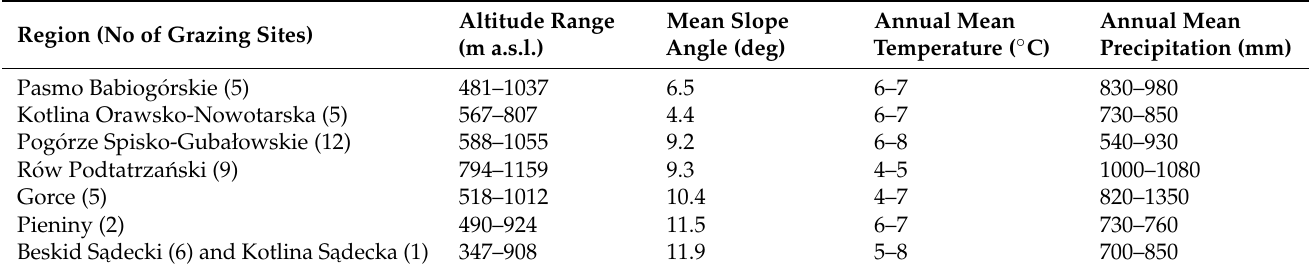
Table 1. Diversity of grassland types in relation to land use in the past. Land use in the 1960s: G-grassland; A-arable